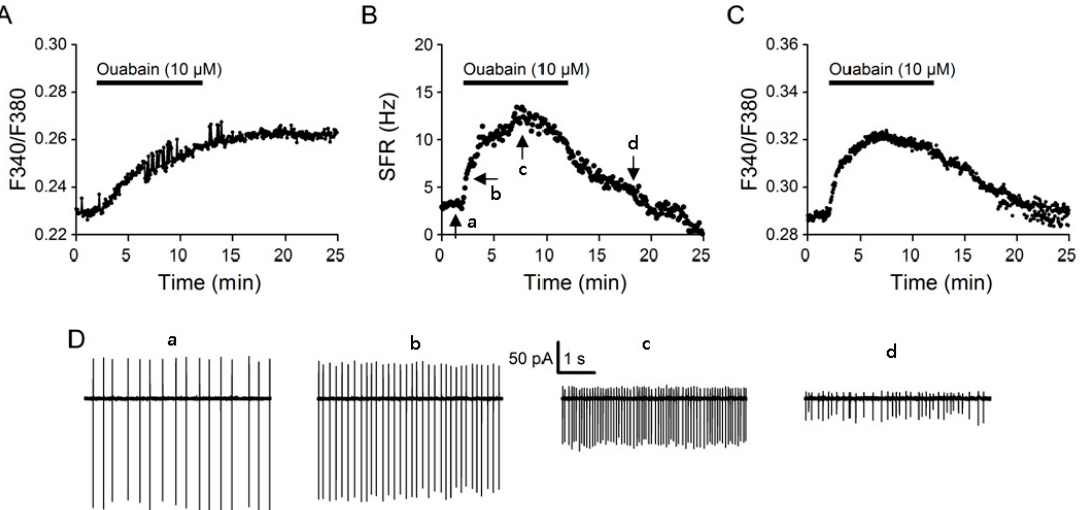
Figure 3. Ouabain effects on [Na + ] i ( A ), spontaneous firing rate (SFR) ( B ), and [Ca 2+ ] i ( C ) from cells in reduced SCN preparations. Representative experiments showing the effect of 10 µM ouabain on [Na + ] i (an average of 28 cells) ( A ) and [Ca 2+ ] i (an average of 21 cells) ( C ). Note the lack of recovery of [Na + ] i after the washout of ouabain. ( B ) A representative cell showing the biphasic effect of 10 µM ouabain on the spontaneous firing rate. The arrows mark where the 6-s action current traces (a,b,c,d) plotted in ( D ) were taken from. ( D ) Four 6-s action current traces (a,b,c,d) recorded with the cell-attached technique to show the effects of 10 µM ouabain on the firing pattern. Note the continuing decrease in the amplitude of spike- and afterhyperpolarization-like current. Similar results were obtained from six other cells.